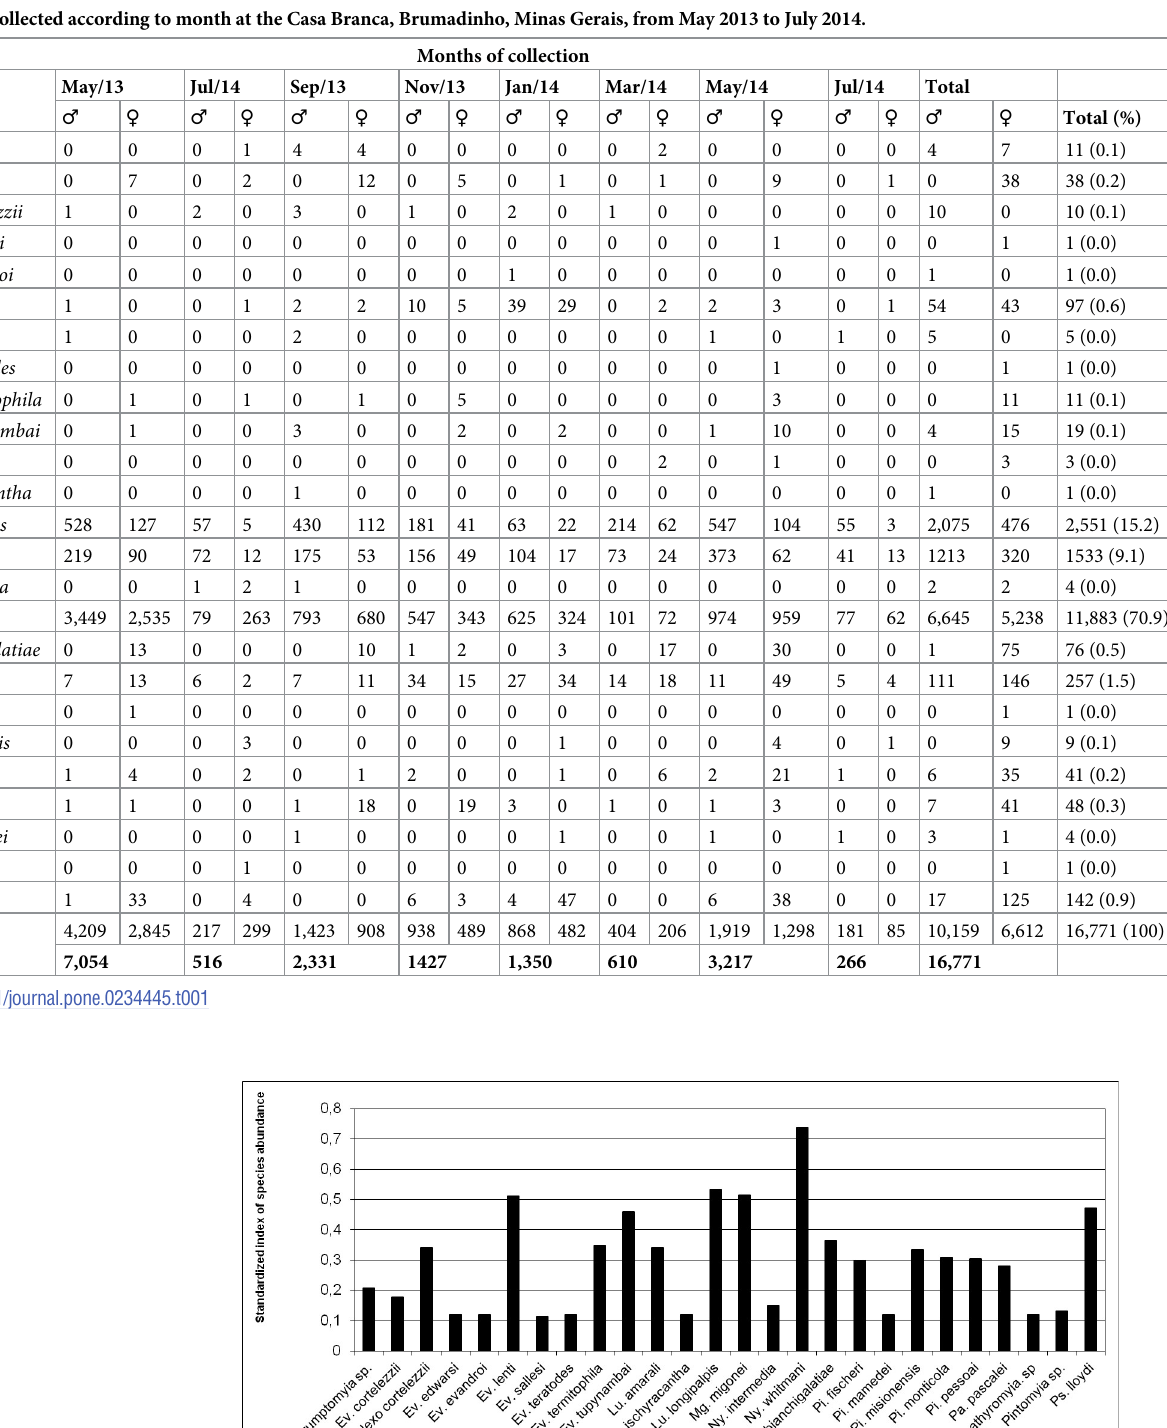
Table 1. Sand flies collected according to month at the Casa Branca, Brumadinho, Minas Gerais, from May 2013 to July 2014. Months of collection